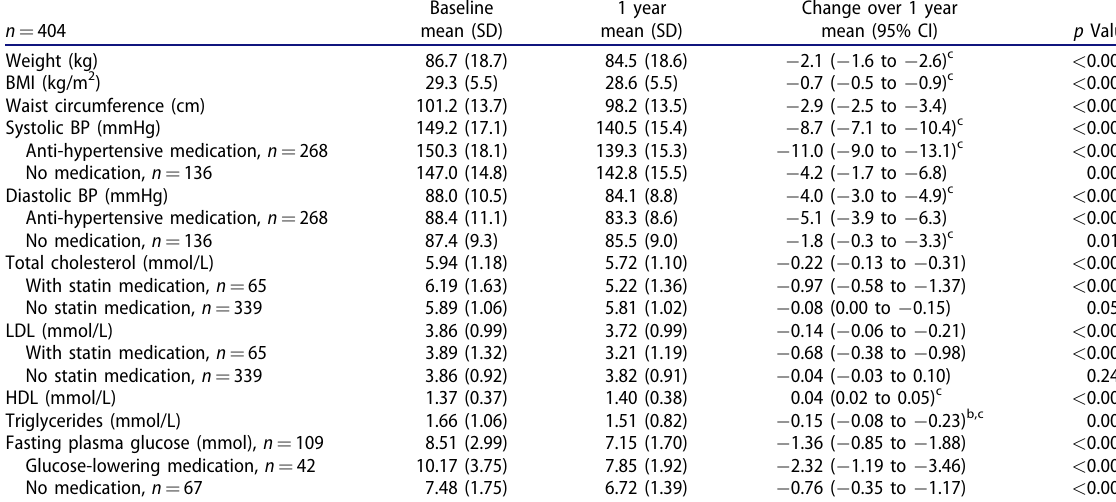
Table 2. Cardiovascular risk factors at baseline, 1year, and change over 1year, total